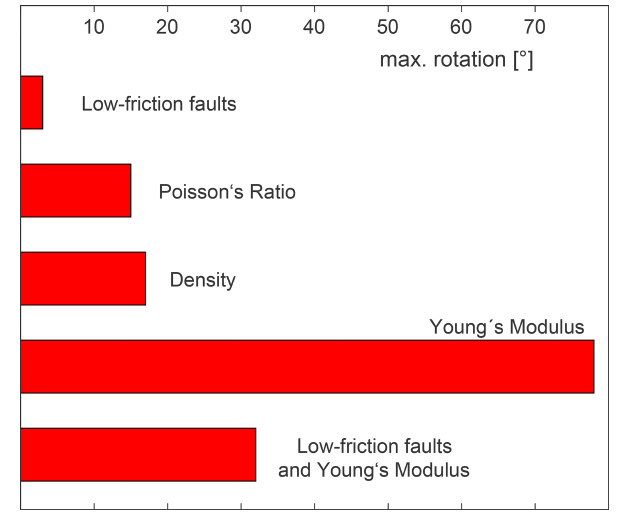
Figure 13. Comparison of resulting maximum stress rotation, based on the geometry used (Fig. 2) and the varied properties (Table